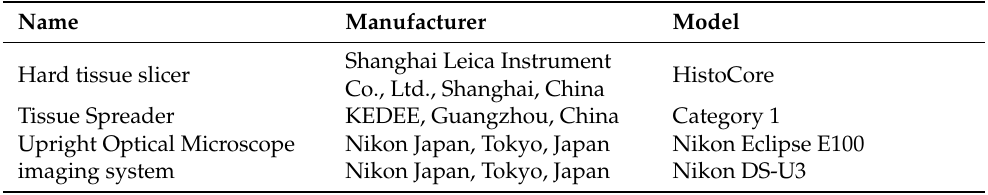
Table 5. Instruments and models used in the